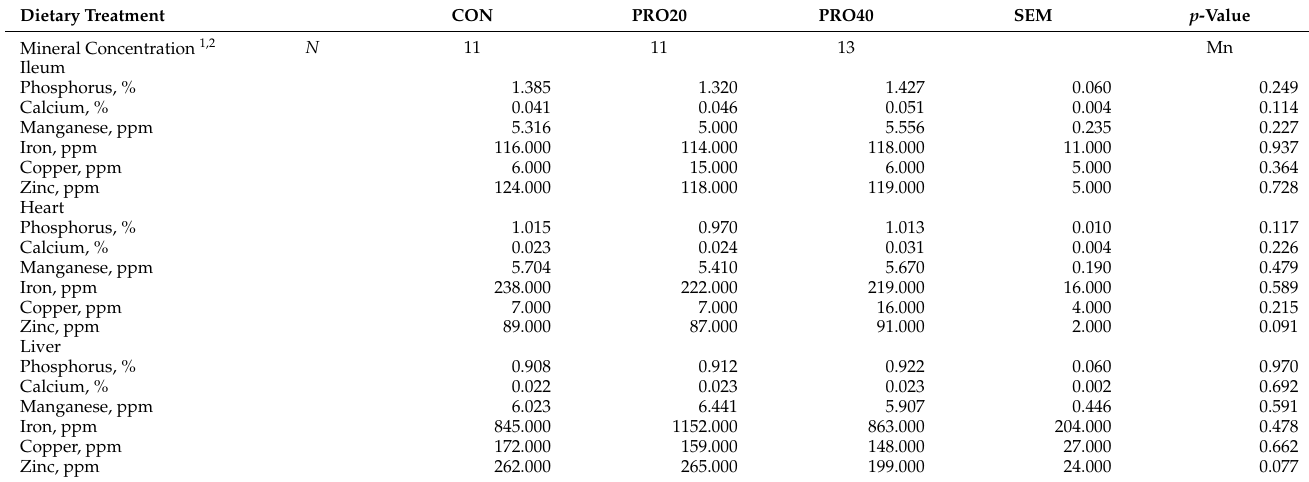
Table 5. The effect of supplemental maternal dietary manganese on tissue mineral concentrations of piglets at